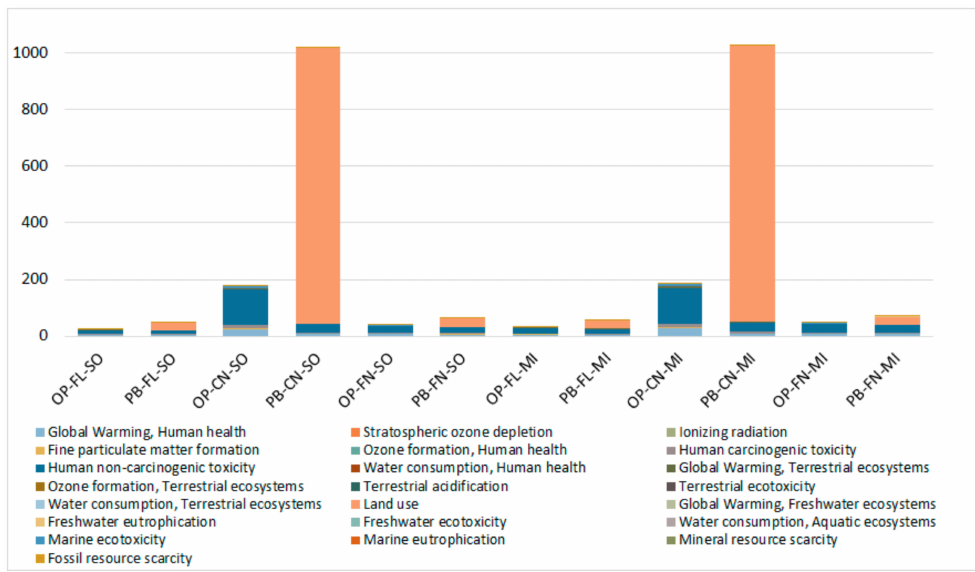
Figure 4. Life cycle environmental impacts of each process path for 1 kg